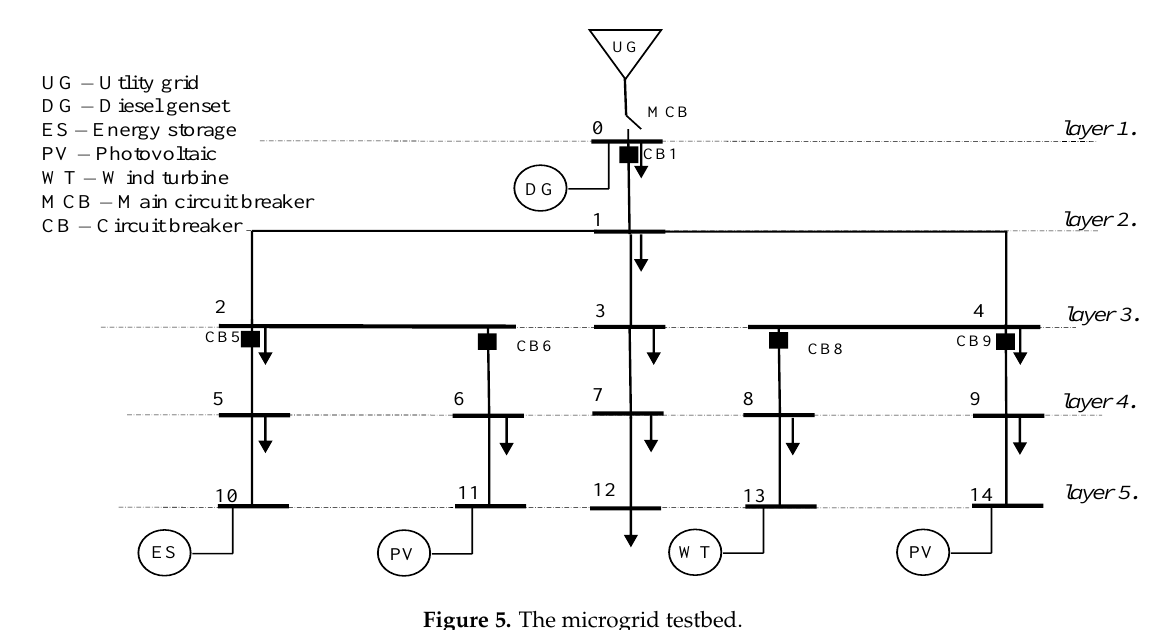
Figure 5. The microgrid testbed. 325